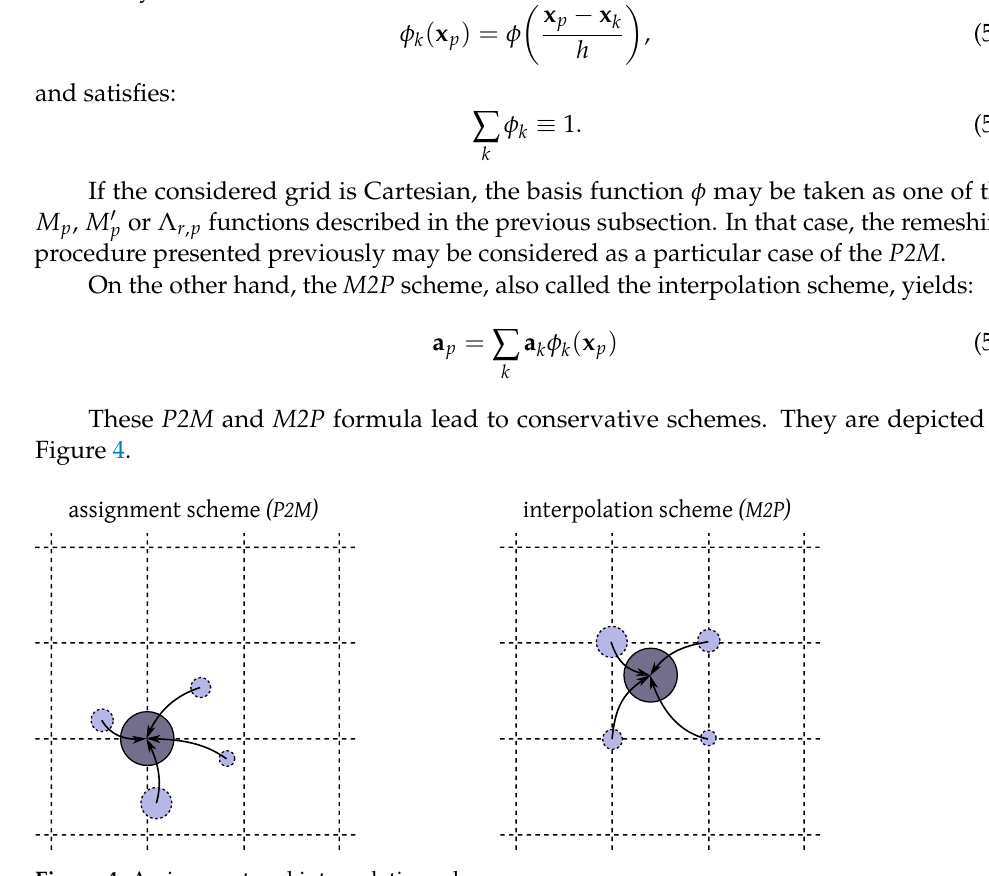
Figure 4. Assignment and interpolation